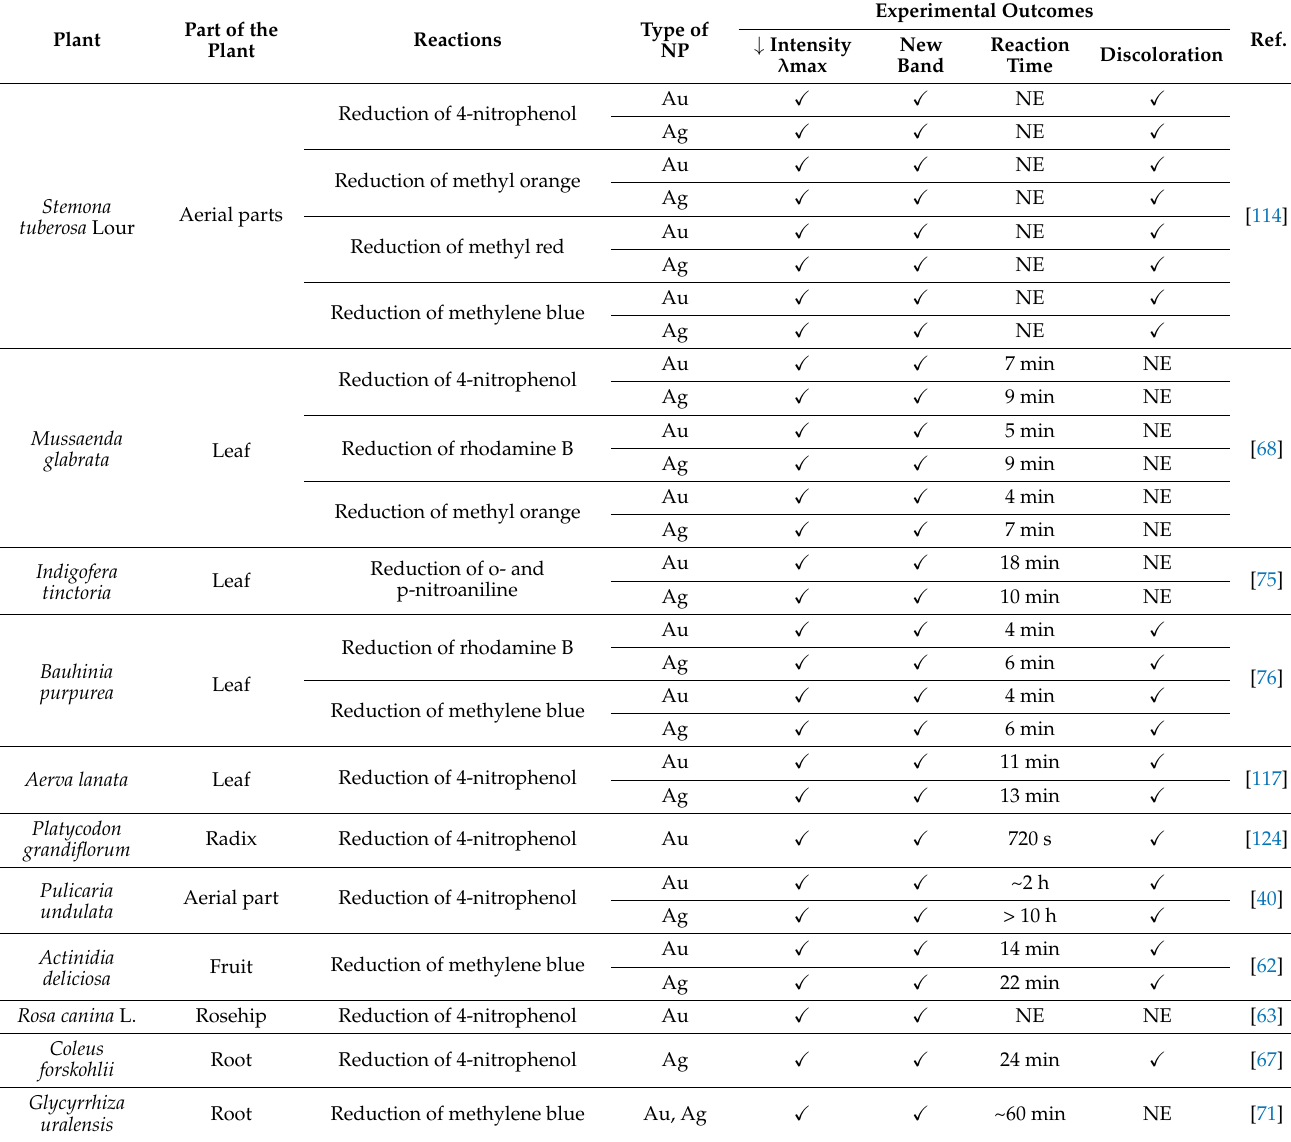
Table 5. Plant-based gold and silver nanoparticles as catalysts.